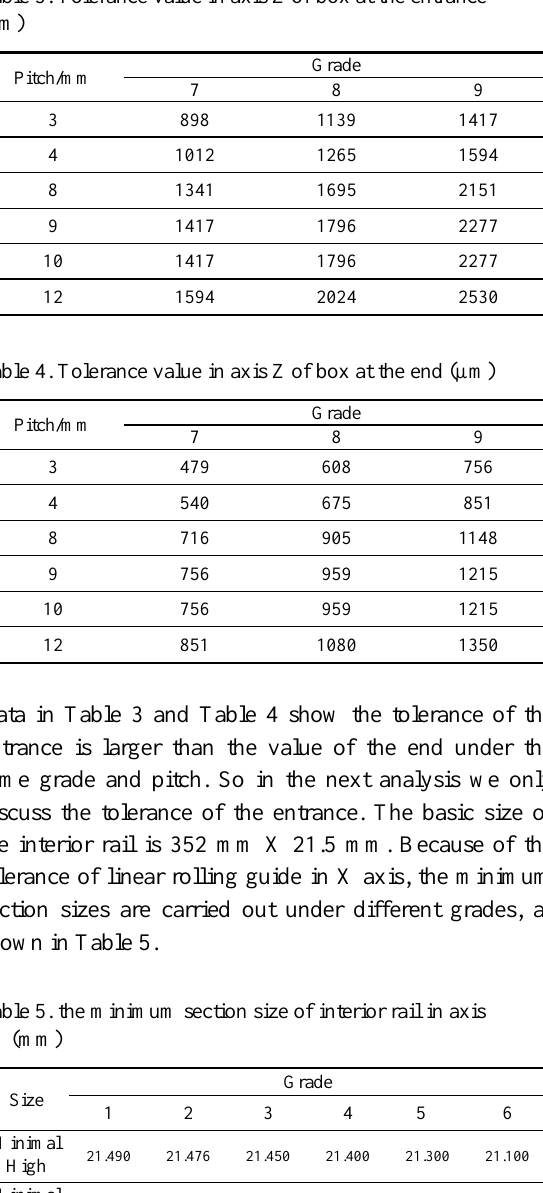
Data in Table 2 show the tolerance of the entrance is larger than the value of the end under the same grade of ball screw. So in the next step of analysis we only dis- cuss the tolerance of entrance. Trapezoidal screw threads are used to move straight in axis Z. According to the national standard GB/T5796.4-2005[16], based on the equations (11) and (12), the tolerance value in axis Z under different accuracy grades of trapezoidal screw threads are figured out as shown in Table 3 and Table 4. Table 3. Tolerance value in axis Z of box at the entrance